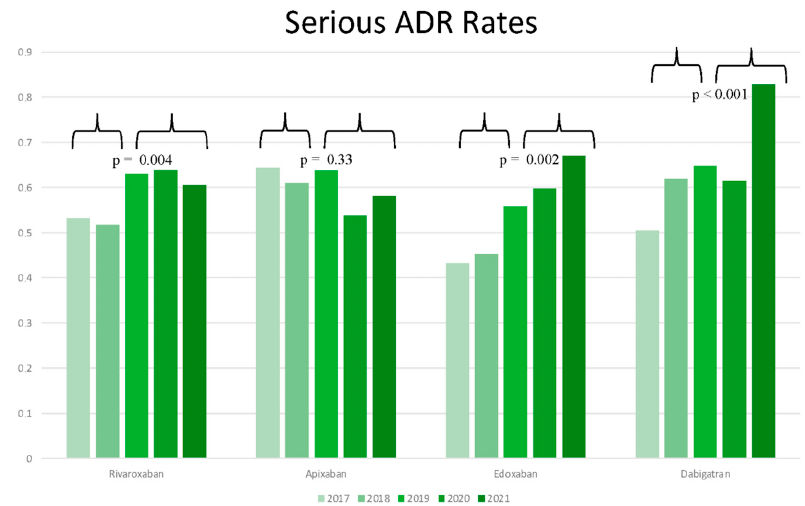
Figure 1. Rates of serious ADR relative to total ADR for each molecule for all study years. Serious ADR rates collected in 2017–2018 were compared to serious ADR rates collected during the period 2019–2021. A p -value ≤ 0.05 was considered statistically significant. ADR: adverse drug reaction.